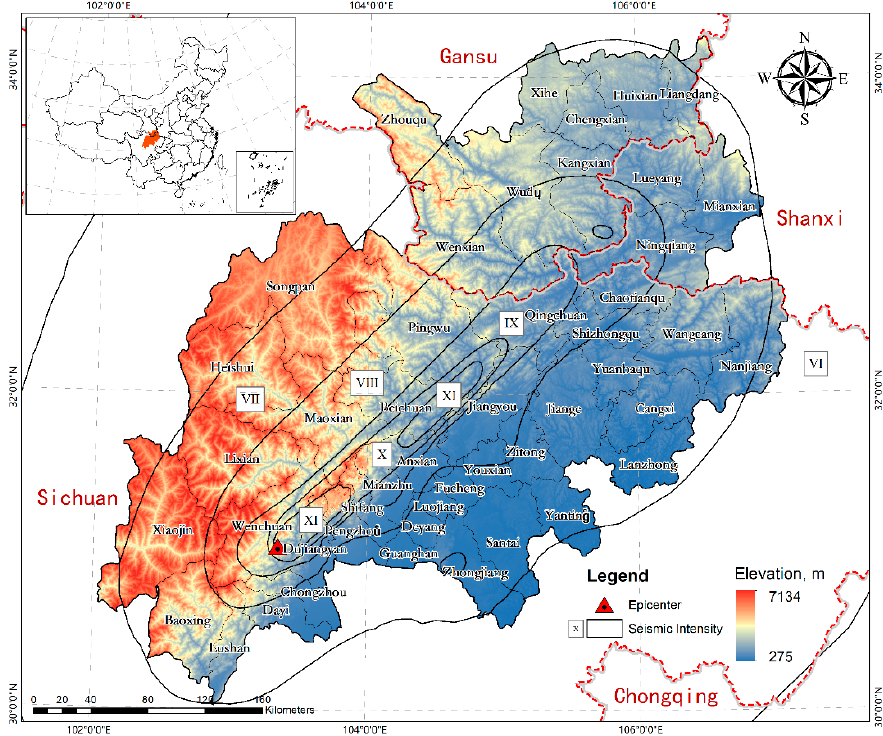
Figure 1. Study area: The worst-hit areas in the Wenchuan Earthquake.